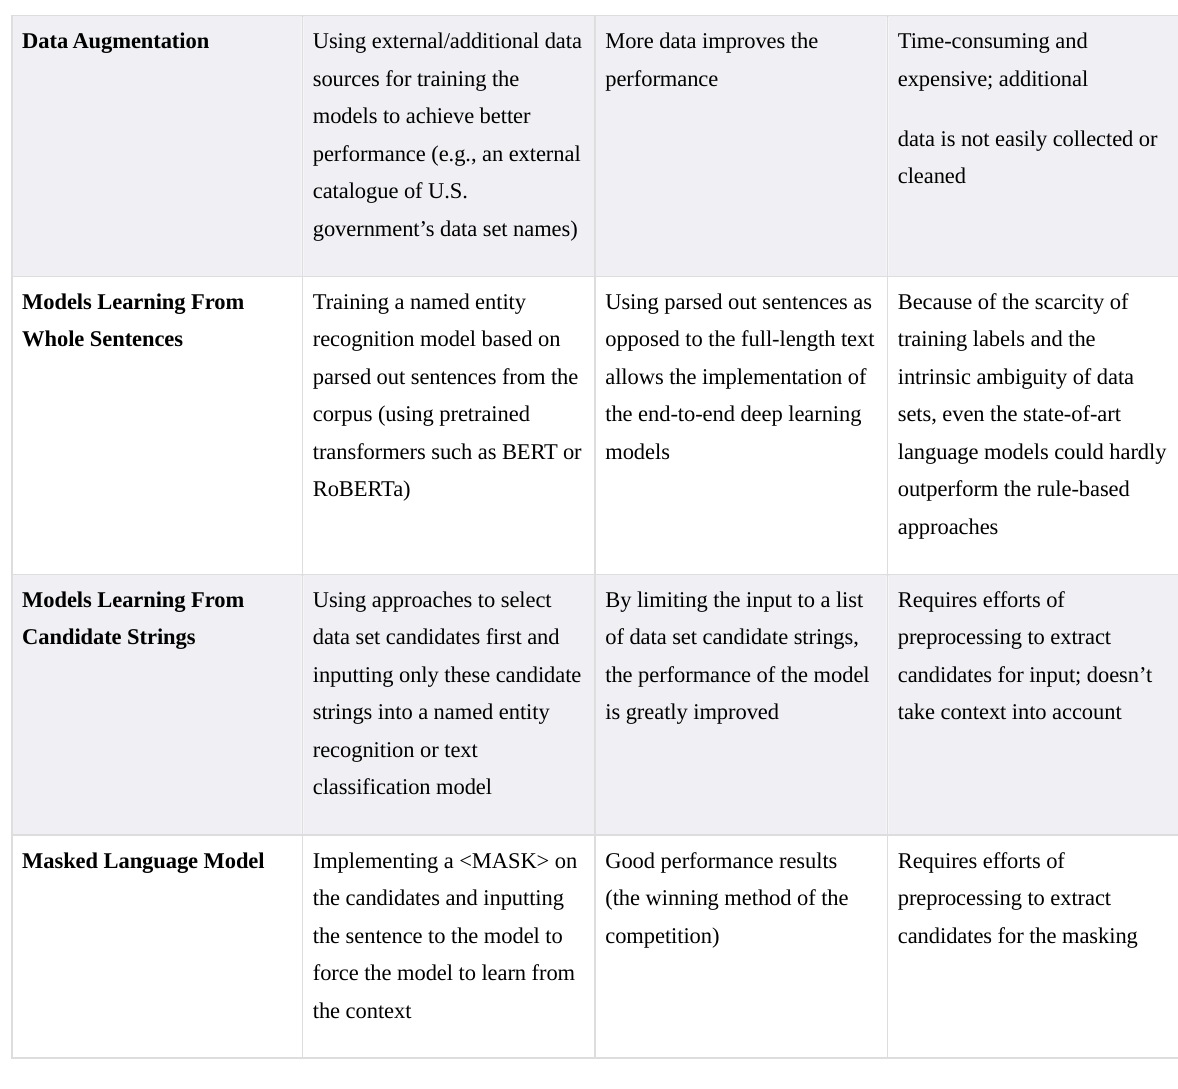
Table 2. Summary of